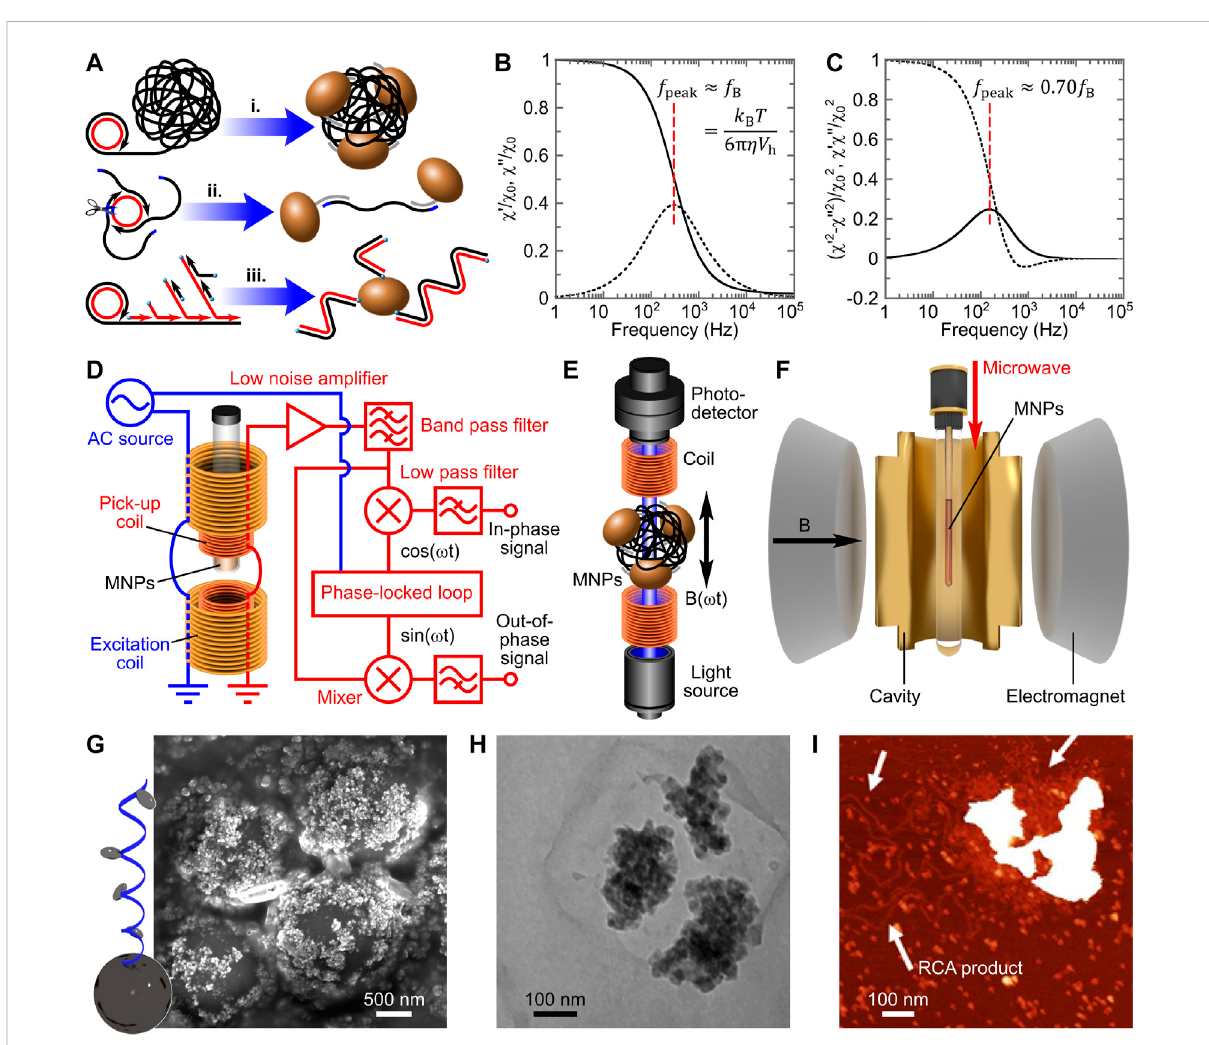
FIGURE 1 The basic principle of volume-ampli fi ed magnetic nanoparticle detection assays. (A) Three typical detection models for the nucleic acid ampli fi cation-based hydrodynamic size increase of MNPs, instanced by conventional, nicking-enhanced, and hyperbranched rolling circle ampli fi cation strategies, respectively. (B) Spectra of normalized in-phase and out-of-phase magnetic susceptibility ( χ ′ / χ 0 and χ ″ / χ 0 ), represented by solidand dashed lines, respectively. (C) Spectra of normalized in-phase and out-of-phase optomagnetic output, correspondingto ( χ ′ 2 − χ ″ 2 ) / χ 2 0 and χ ′ χ ″ / χ 2 0 inACsusceptometry,representedbysolidanddashedlines,respectively.Panels (B,C) areadaptedwithpermissionfromTianetal.(2017), Copyright2017, American Chemical Society. Detection schematics of (D) ACsusceptometer (with alock-in ampli fi er), (E) optomagneticsensor, and (F) ferromagnetic resonance spectrometer. Panel F is adapted with permission from Tian et al. (2018a), Copyright 2018, American Chemical Society. (G) Scanningelectronmicroscopymicrographofcore-satellitemagneticsuperstructureswith100 nmMNPsatellites.Adaptedwithpermissionfrom Tianetal.(2018b),Copyright2017, AmericanChemical Society. (H) Transmissionelectron microscopymicrograph of130 nmMNPsaggregated bya DNAcoil (only asalt precipitatecan beobserved). Adapted with permissionfrom Akhtar et al. (2010), Copyright2010,AmericanChemicalSociety.